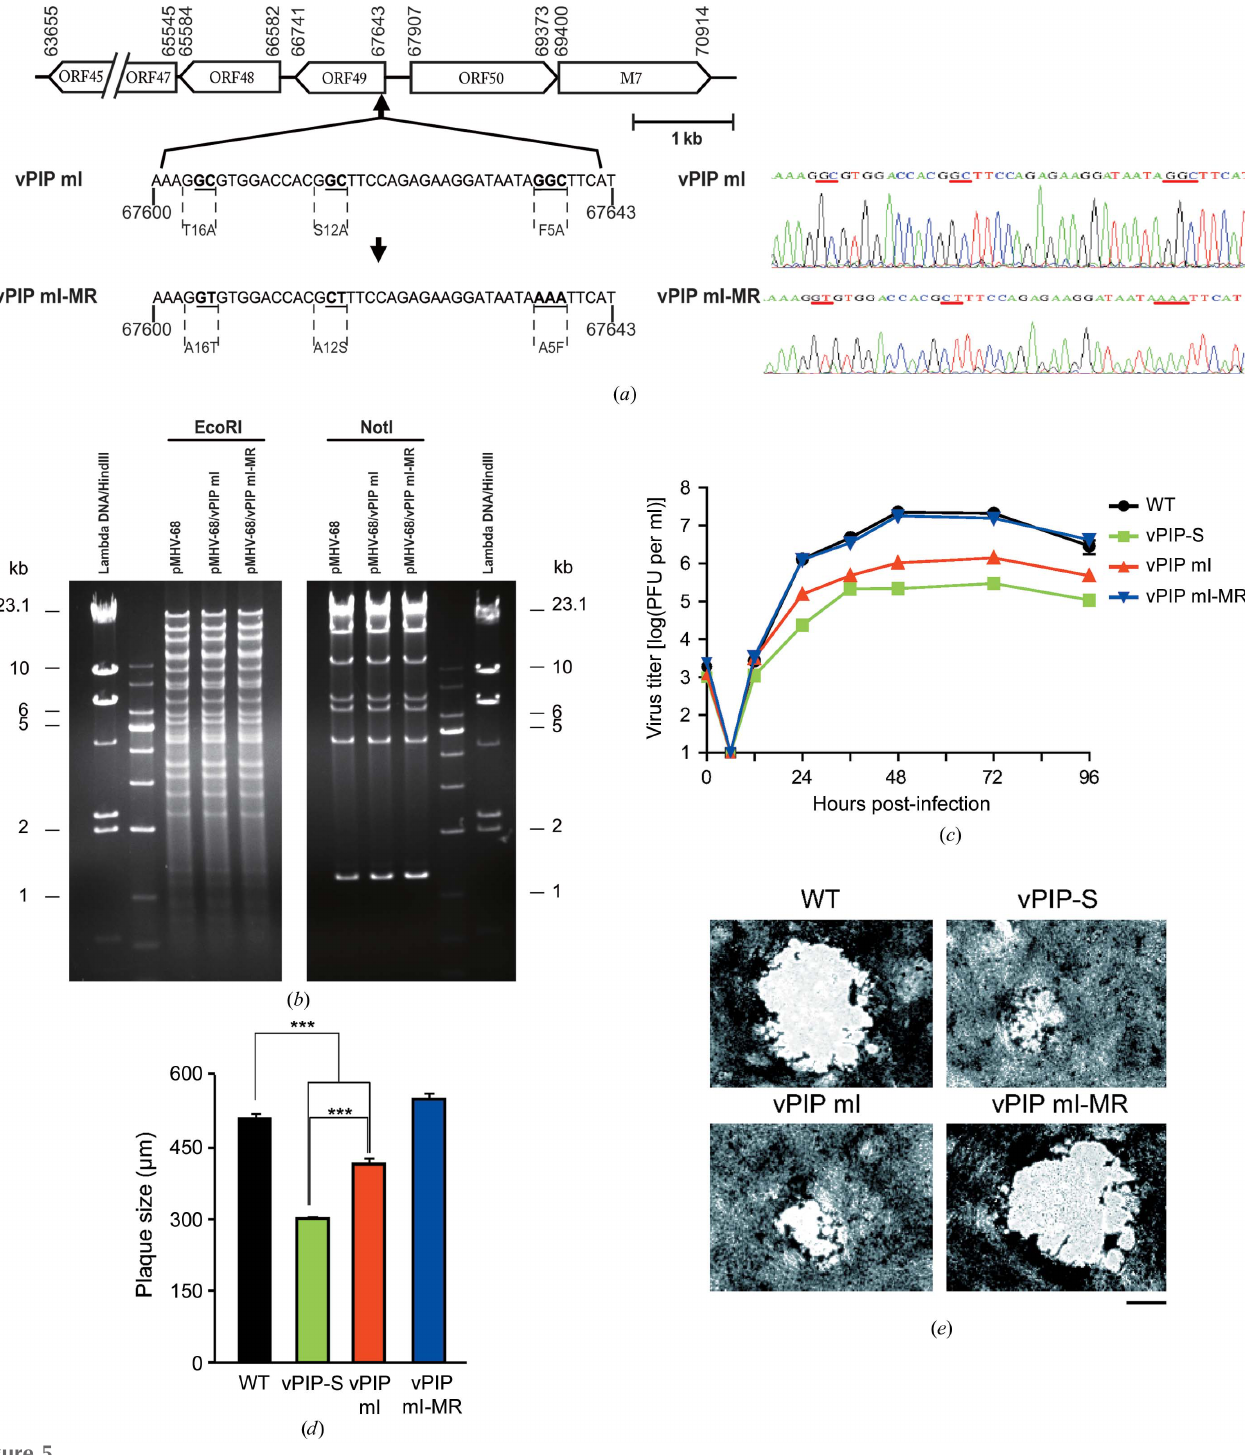
Figure 5 Creation and in vitro replication of the mutant virus (vPIP mI). ( a ) A schematic diagram of the ORF49 gene locus in the MHV-68 genome. Open reading frames are shown as boxes. The arrowheads of the boxes indicate the direction of transcription. The numbers indicate the positions of each part within the viral genome. The recombinant viruses vPIP mI and vPIP mI-MR were constructed as indicated and the mutated positions in the recombinant viruses were confirmed by sequencing. ( b ) The genome integrity of the recombinant virus BAC clones was verified by digestion with the EcoRI or NotI restriction enzyme. ( c ) Multiple-step replication curves of the WT, vPIP-S, vPIP mI and vPIP mI-MR viruses. BHK21 cells were infected with the WT, vPIP-S, vPIP mI or vPIP mI-MR virus in triplicate at a multiplicity of infection (MOI) of 0.05 and were harvested at the indicated time points. The virus titers in the cells and the supernatants were analyzed by plaque assays. ( d , e ) Plaque sizes of the WT, vPIP-S, vPIP mI and vPIP mI-MR viruses. Plaque assays were performed on Vero cells and the diameters of the plaques were determined for at least 100 plaques per virus. The average plaque sizes are shown with the standard error in ( d ). Statistical analysis was performed by a two-sided Student’s t-test (*** denotes P < 0.005). Representative pictures of actual plaques are shown in ( e ). The scale bar is 200 m m in